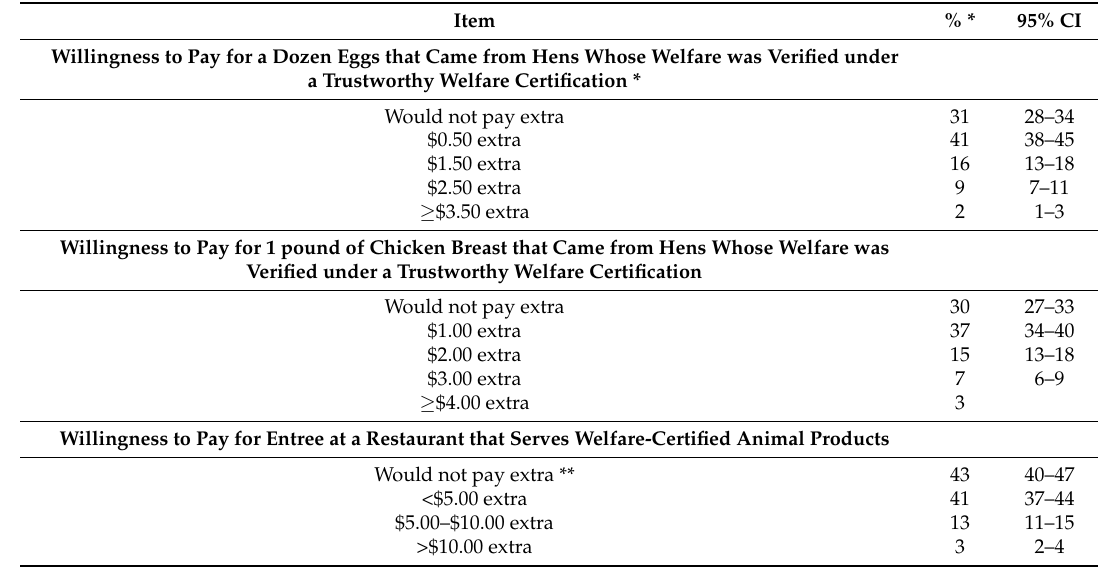
Table 4. Consumer willingness to pay for welfare-certified meat, eggs, and dairy. Item % * 95%